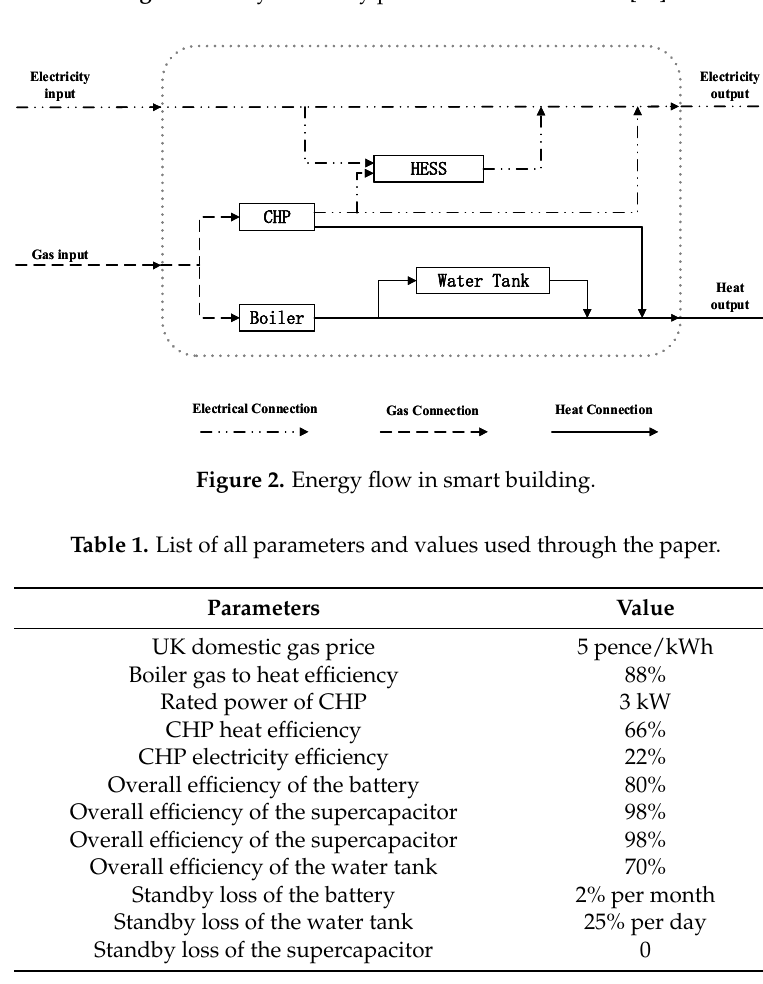
Figure 1. Daily electricity price in different seasons [23].